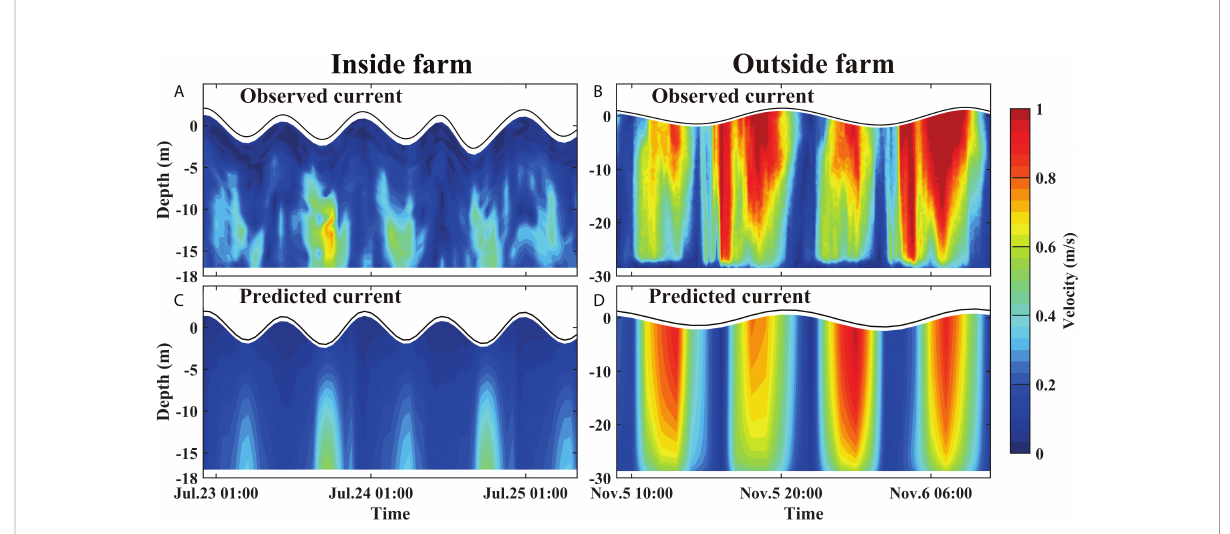
FIGURE 7 Model-data comparisons of time series of current pro fi le at S1 station inside the farm (Left) and S4 station outside the farm (Right). (A) observed & (C) predicted current pro fi le at S1. (B) observed & (D) predicted current pro fi le at S4.